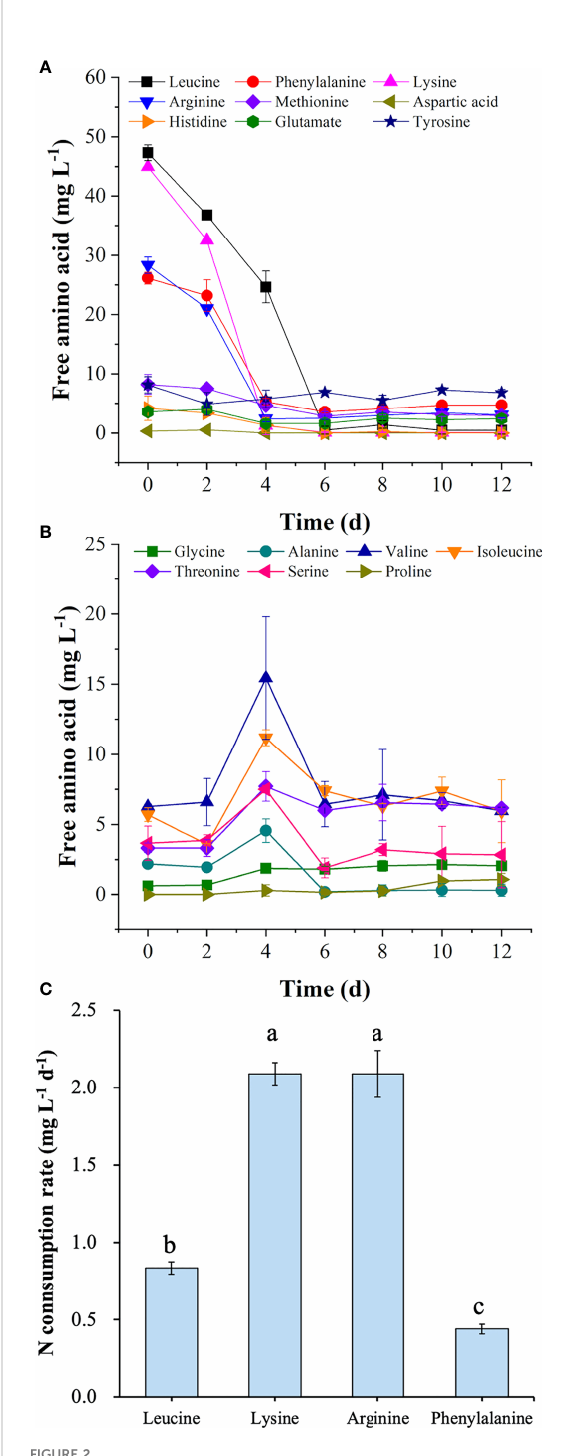
FIGURE 2 Concentrations of preferred free amino acids (A) and other free amino acids (B) in the medium and nitrogen consumption rates of four preferred amino acids (C) in the mixotrophic growth of Phaeodactylum tricornutum using organic nitrogen source (tryptone:urea = 1:1, mol N:mol N) at 20 mmol N L − 1 . Different letters represent signi fi cant difference